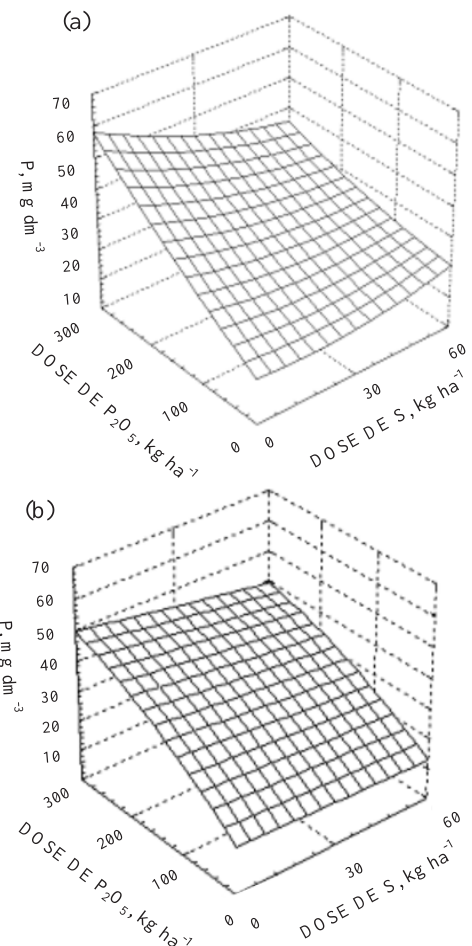
Figura 5. Superfície de resposta, para a concentração de fósforo no solo extraído pela resina de troca aniônica como variável da fonte